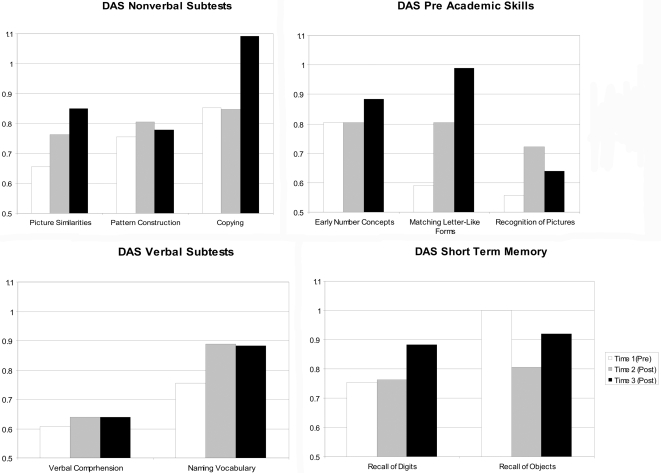
Rates of development for DAS subtests.A rate of “1” (vertical axis) indicates typical development (i.e., developmental age equals chronological age). For example, at age 4, performance at the level of a 4 year old would yield a rate of development of 1 (4/4). In contrast, at age 4, a performance at the level of a 3 year old would yield a developmental rate of 0.75 (3/4). Subsequently, a score of <1 indicates performance (developmental age) below that expected for chronological age.